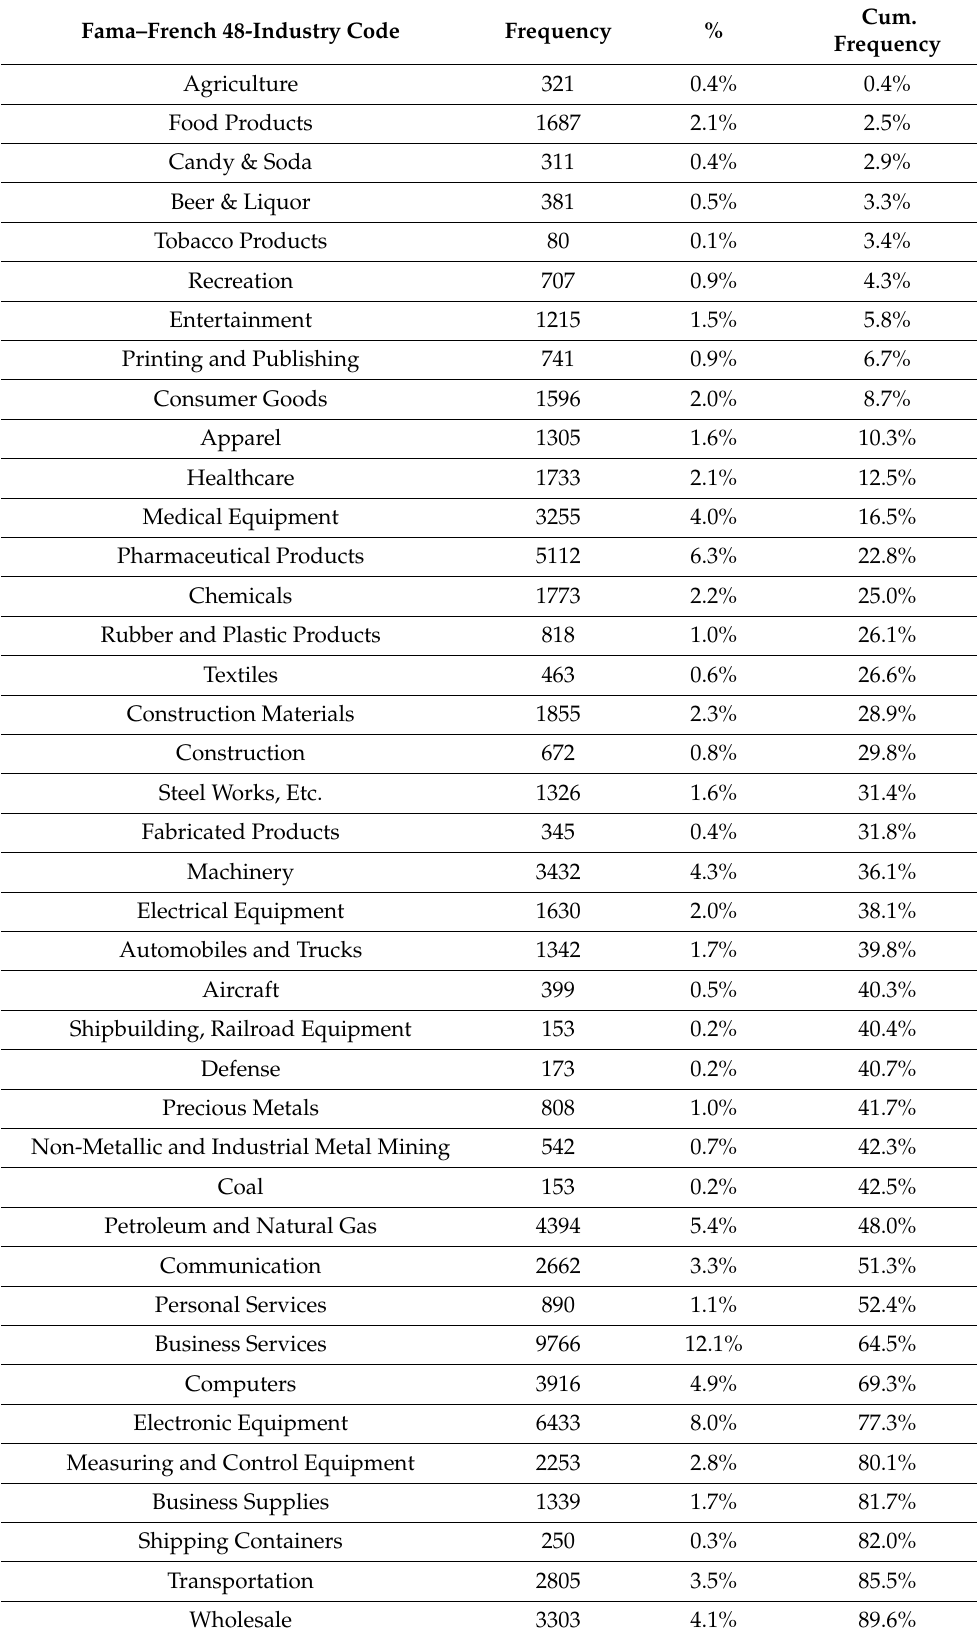
Table 1. Sample distribution of the sample according to the Fama and French 48-industry classifica- tion